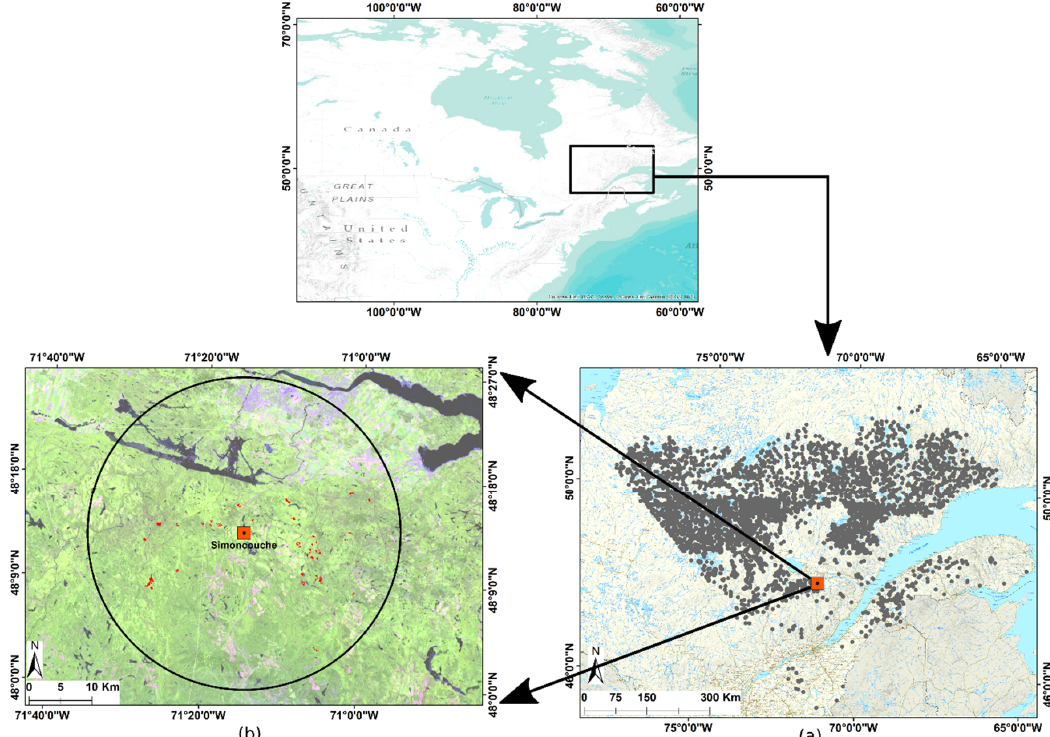
Figure 1. Location of the 5000 black spruce stands in Quebec, Canada ( a ) selected from two ISIN tiles (h13 v03 and h13 v04, not shown) of MODIS, and the stand where phenological phases were measured ( b ). The zoomed-in area shows the 40 black spruce polygons (in red color) used for calibration within the buffer of 25 km 2 around the field observation site.